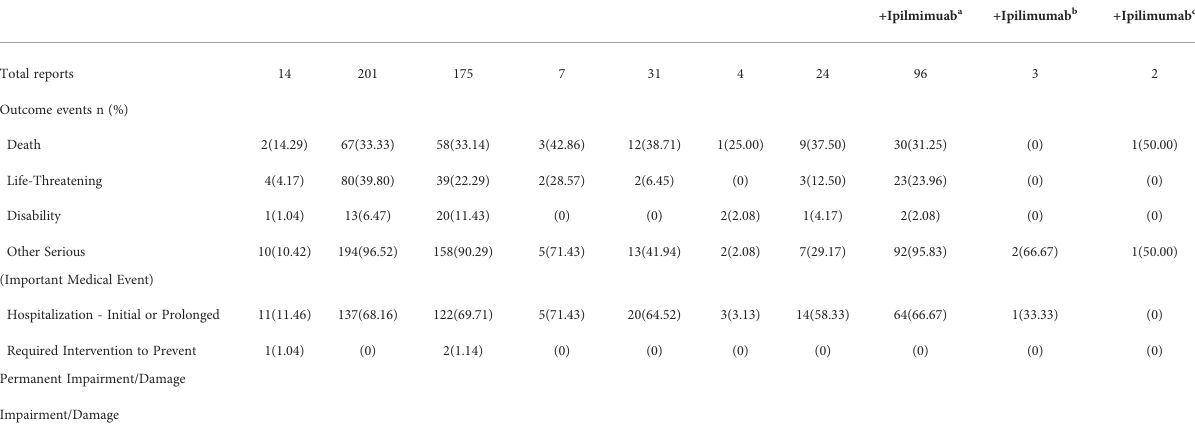
TABLE 6 Outcome